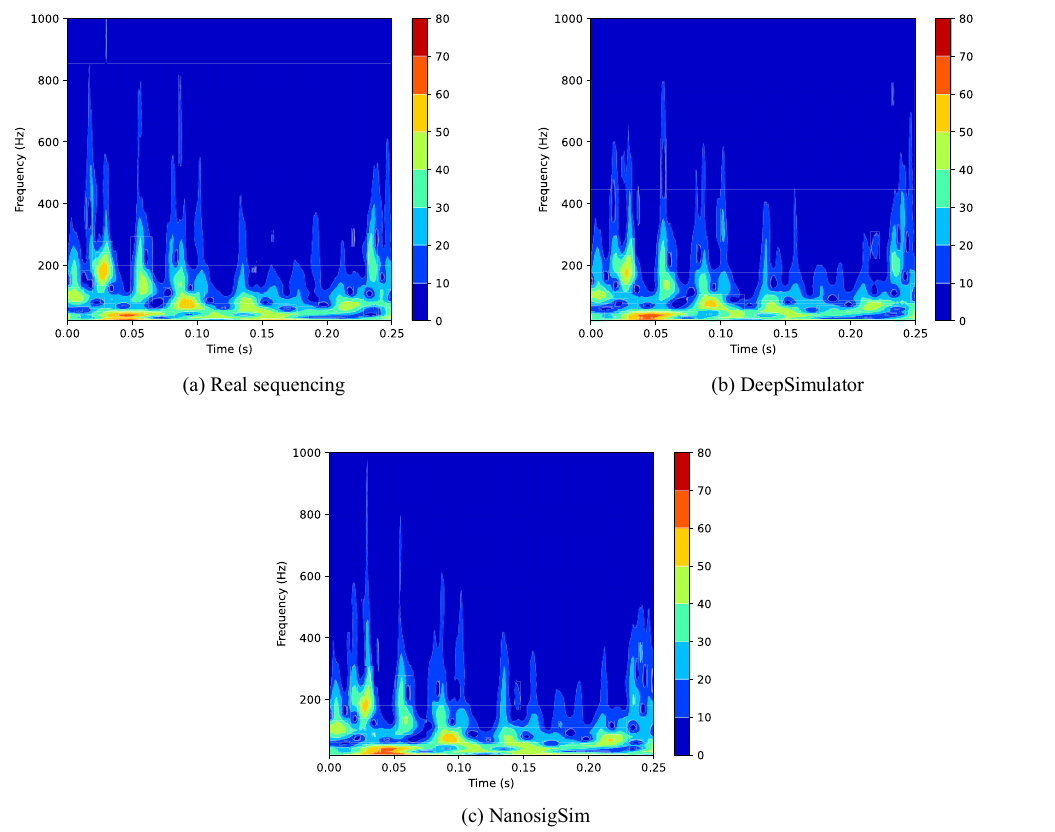
Figure 10. The CWT spectrums of: ( a ) the real sequencing signal; ( b ) the simulated signal from DeepSimulator; and ( c ) the simulated signal from NanosigSim. The CWT spectrum for NanosigSim is more similar to the spectrum for the real signal than that for DeepSimulator, which means that our proposed method is